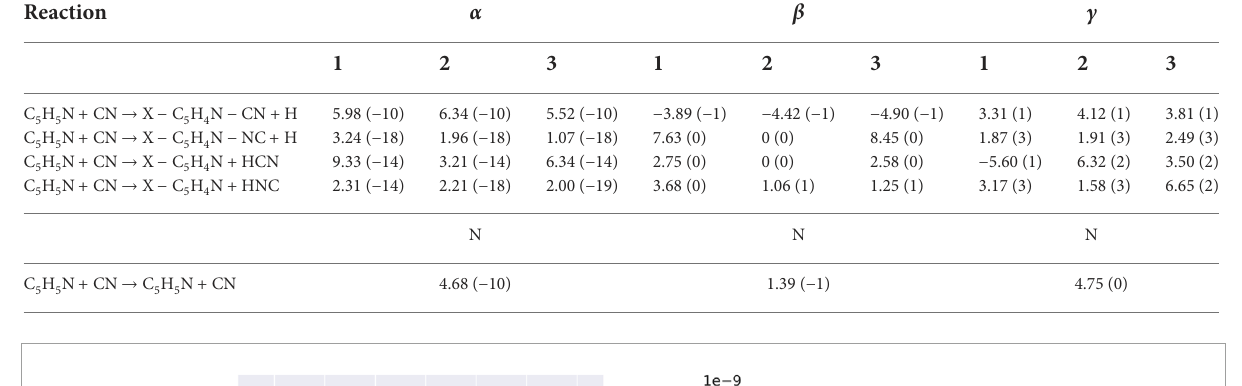
TABLE 5 Bestfittingparameters α (incm 3 s −1 ), β (dimensionless), γ (inK)forthereactionsinthecarbonorhydrogenatomsconsideredinthisworkandfor theback-dissociationreaction.ThenotationA(B)represents A ×10 B units.NotethatthefitsforC 5 H 5 N + CN → X − C 5 H 4 N + HNCdivergeatlow temperatureandarenotwellfittedbyanArrhenius-Kooijexpression. Reaction